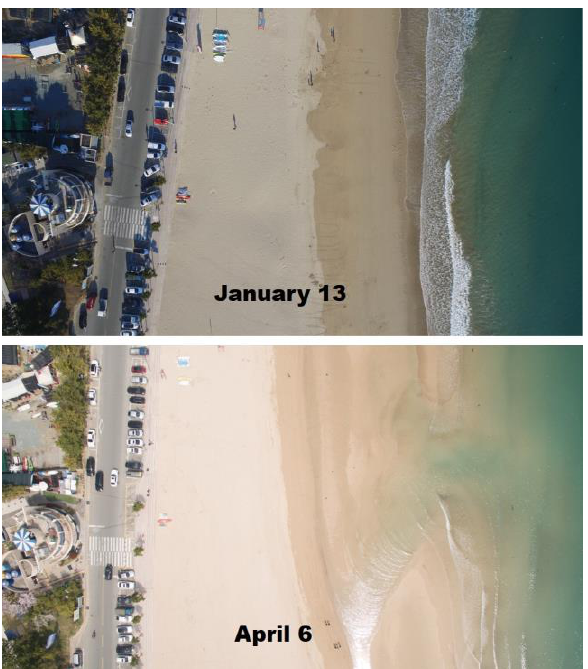
Figure 4. Aerial images acquired by UAV on Songjung